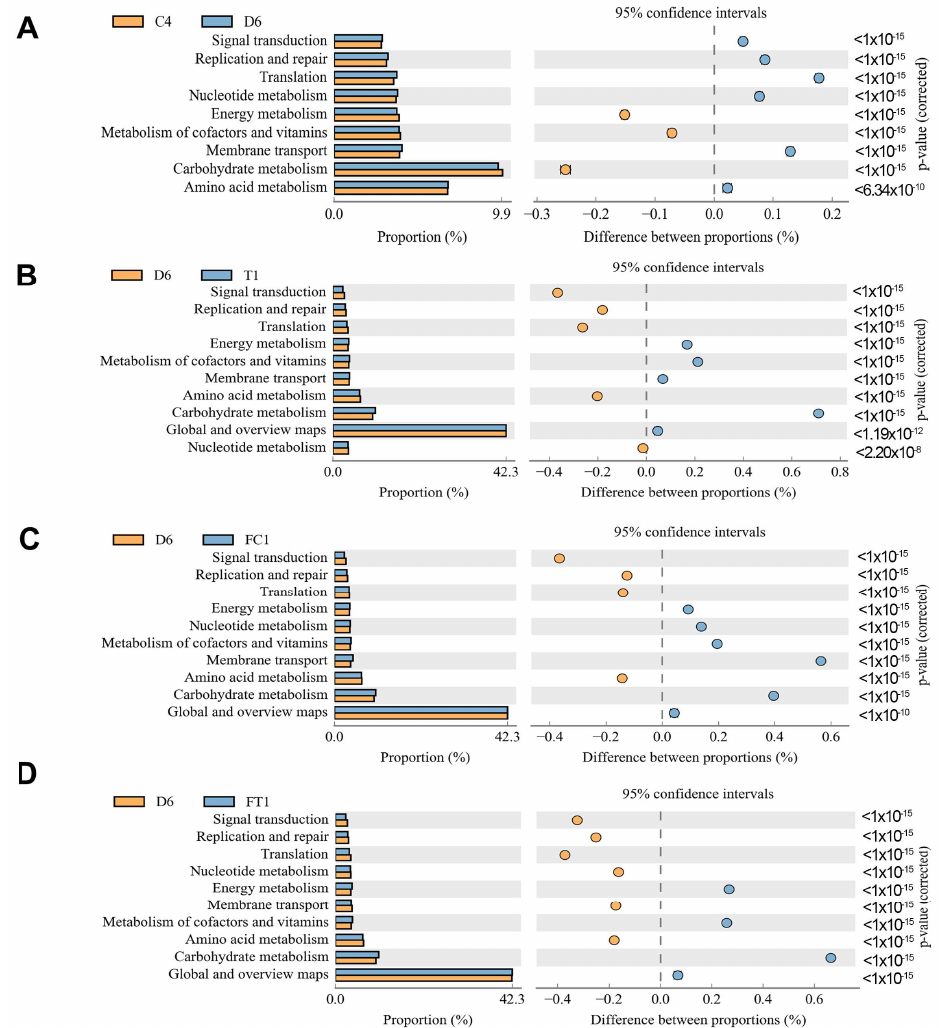
Figure 7. Predicted metabolic differences associated with different treatment in microbial communities found in the feces. Metabolic pathway was identified using PICRUSt software. ( A ) Difference with Control and DSS group in microbial communities; ( B ) Difference with DSS and Taxifolin group in microbial communities; ( C ) Difference with DSS and FC group in microbial communities; ( D ) Difference with DSS and FT group in microbial communities.